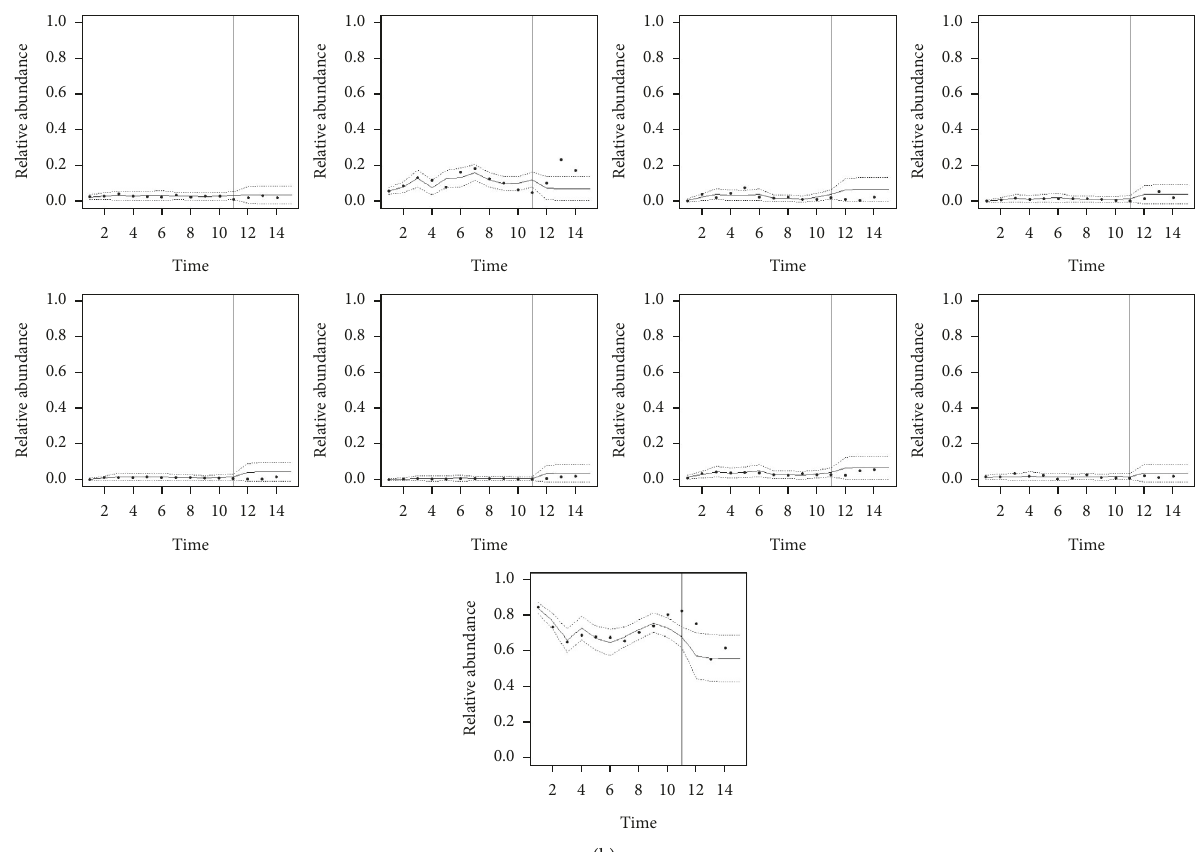
Figure 2: Model estimation and prediction at family taxonomic level. Black points represent the data, the black line represents the expected value obtained with the proposed model, and dashed lines represent the value of E when the estimation of the model finishes and the prediction starts. (a) Female: the families of bacteria are, from left to right, o_bacteroidales; f _, other , f_erysipelotrichaceae , o_clostridiales ; f_, f_lachnospiraceae , f_ruminococcaceae , f_veillonellaceae , f_desulfovibrionaceae , and f_bacteroidaceae . (b) Male: the families of bacteria are, from left to right, f_alcaligenaceae , f_bacteroidaceae , f_lachnospiraceae , f_por- phyromonadaceae , other , f_rikenellaceae , f_ruminococcaceae , f_veillonellaceae , and f_prevotellaceae